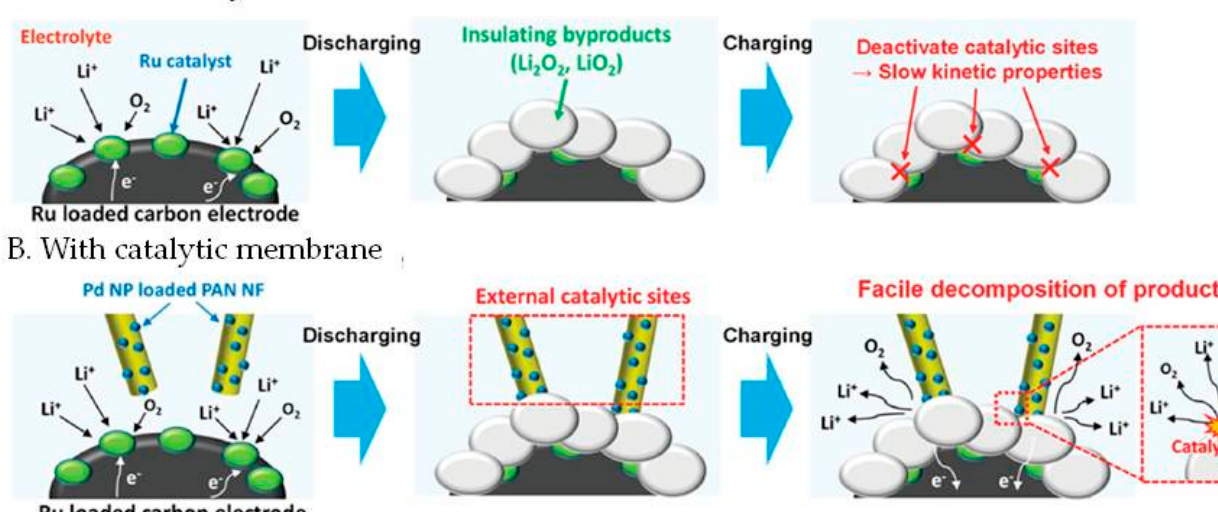
Figure 6. Cathode membranes at Li-Air battery: ( A ) Ru/C electrode without catalytic membrane and ( B ) Ru/C electrode with Pd NP/PAN NF membrane. Reprinted/adapted with permission from Ref. [71]. Copyright 2015, copyright ACS.